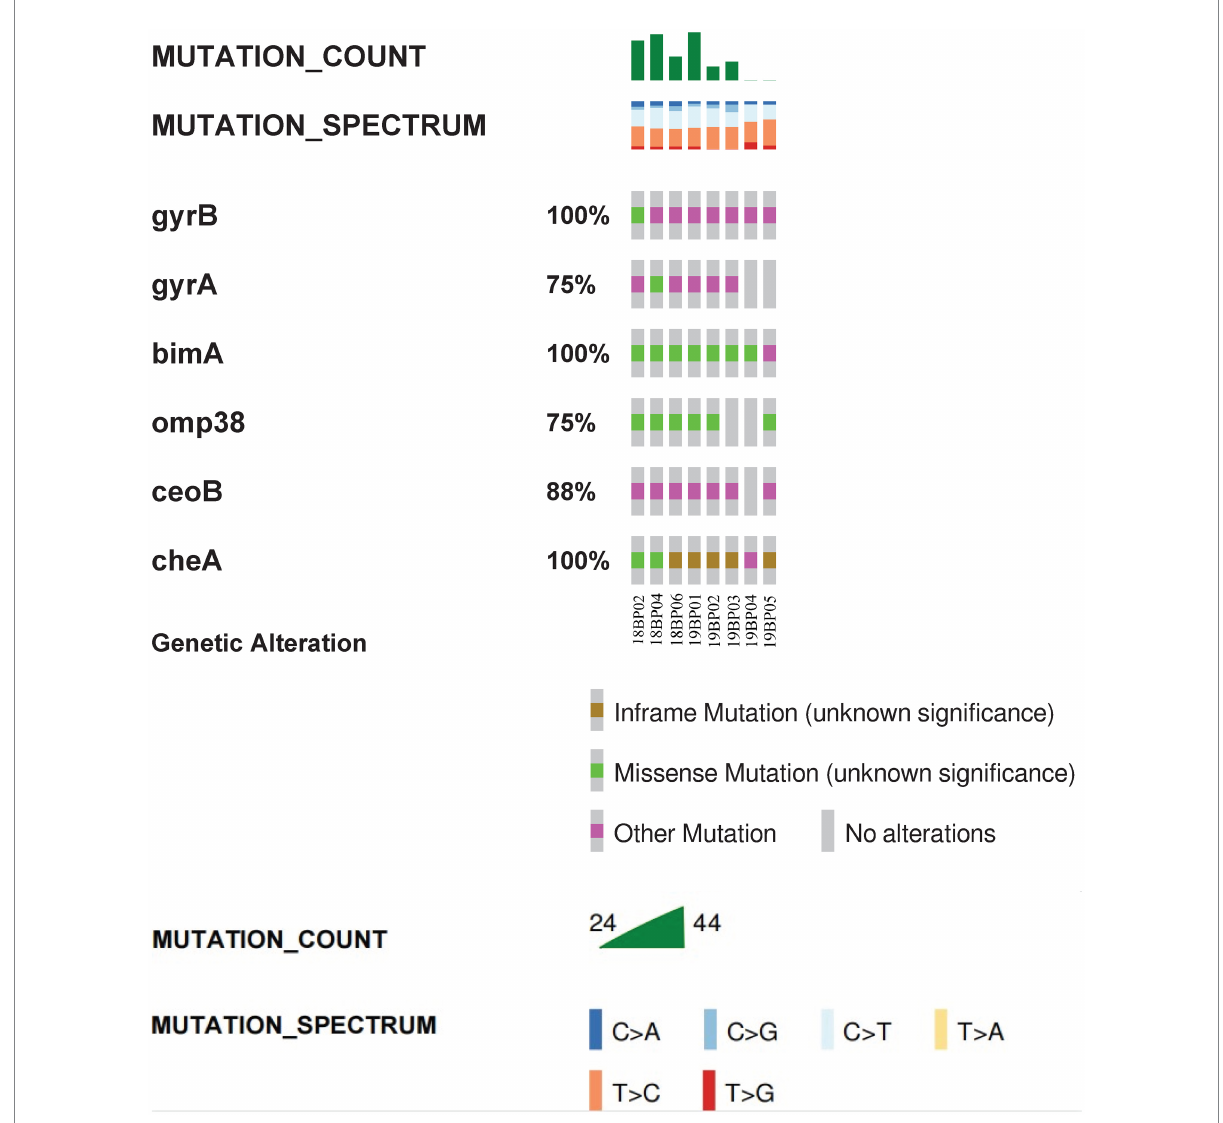
FIGURE 3 Visual summary of bimA , ceoB , cheA , gyrA , gyrB and omp38 . The OncoPrint tool of cBioPortal summarizes genomic alterations in all queried genes across a sample set. Each row represents a gene, and each column represents a sample. The green bars indicate missense mutations, brown bars indicate inframe mutations, and purple squares indicate unknown types of mutations. Mutation count is the total number of mutations for the six genes in the sample, while the different colors represents the different types of base